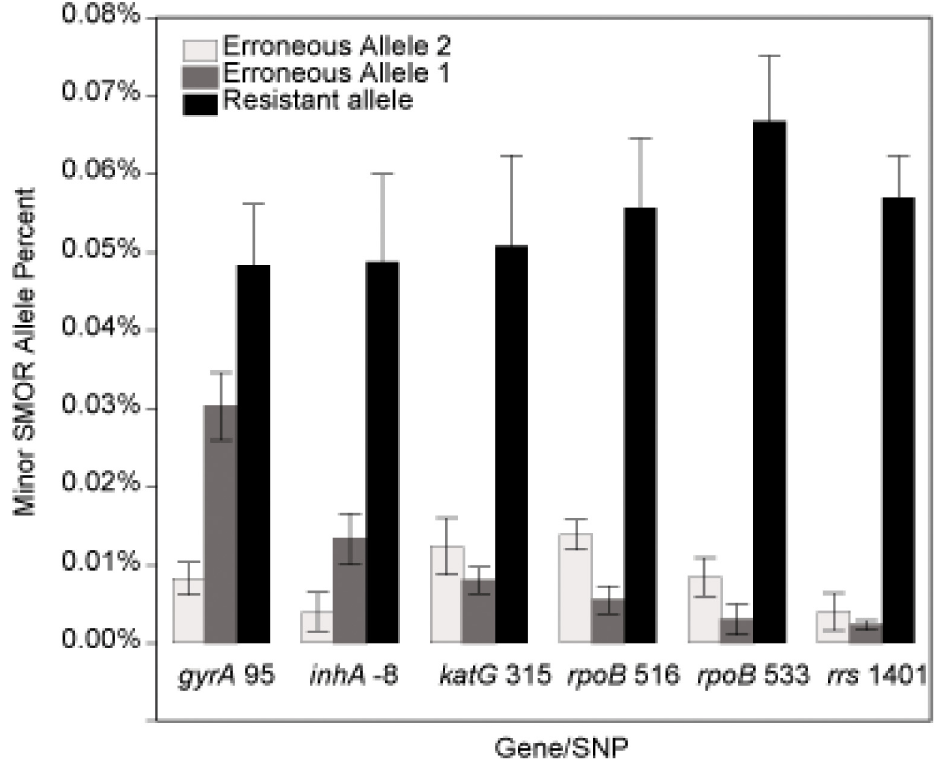
Fig 4. Variation of erroneous alleles. Average frequency (five replicates) of the resistant allele compared to the erroneous alleles at six specific SNP loci from the 0.05:99.95 XDR:Pan-susceptible mixture. Each error bar is constructed using 1 standard deviation from the